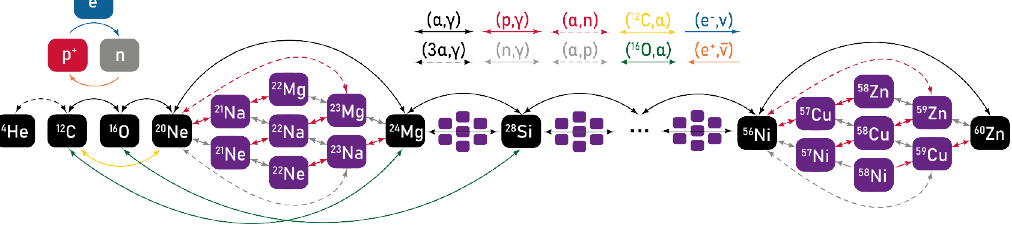
Figure 1. Schematics of the net87 network, showing the α , p , and n reactions in the first and last cluster nodes (in purple) between α -chain elements (in black). Three heavy-ion reactions are also included as they are the main seeds for α particles. Finally, the e − and e + captures are depicted on the